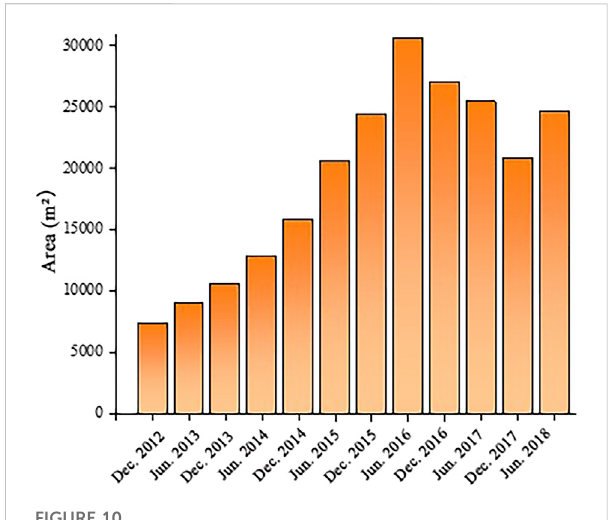
FIGURE 10 Area of strong deformation zone in the vertical direction.